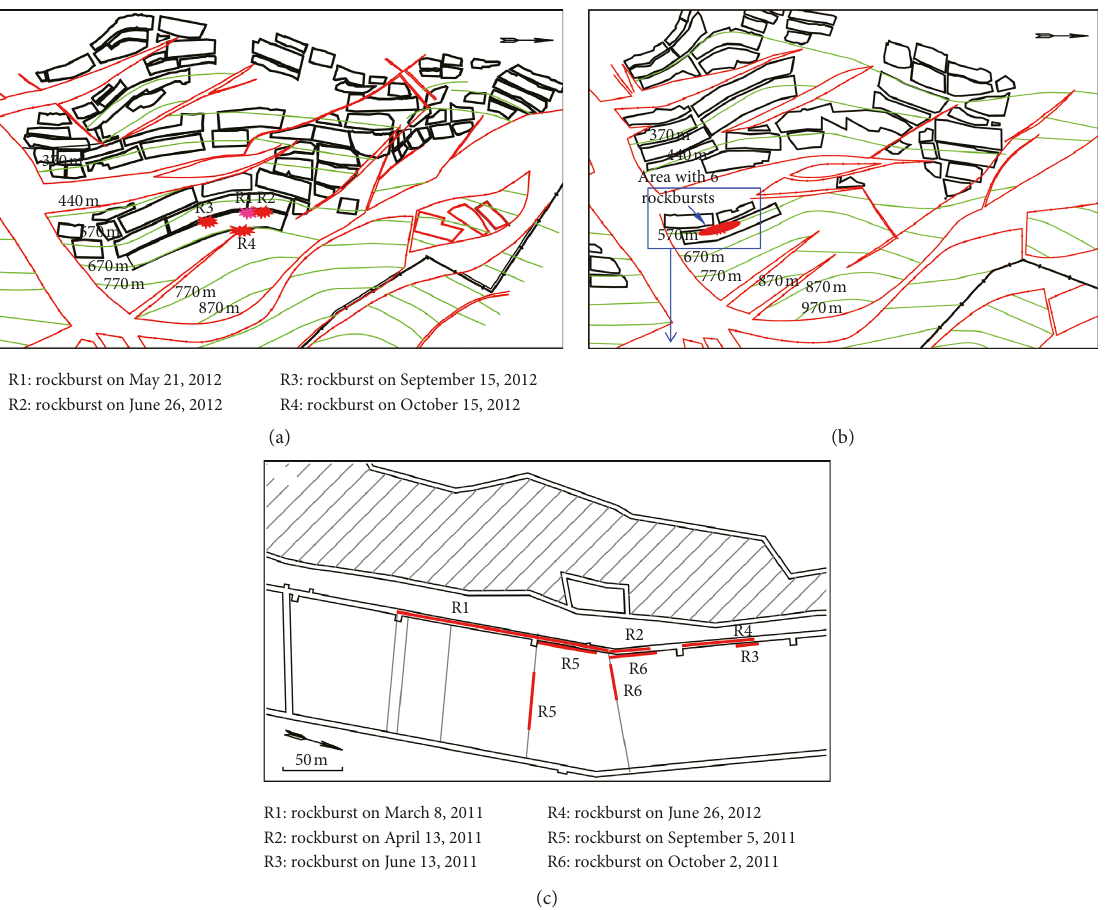
Figure 1: Rockbursts in coal seams 11 (a), 17 (b), and 17’s local magnification (c) when the mining depths of Xing’an Coal Mine approached 600m. Table 1: Further details related to the consequences of rockbursts. Coal seam